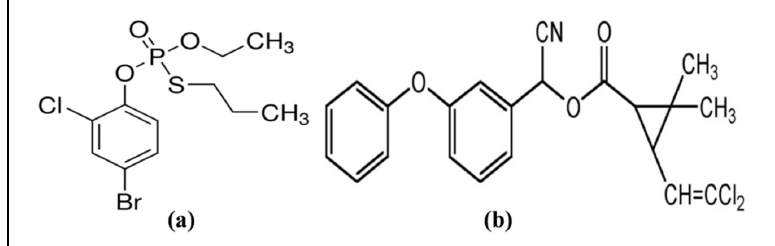
Figure 1. Chemical structure of (a) profenofos and (b)